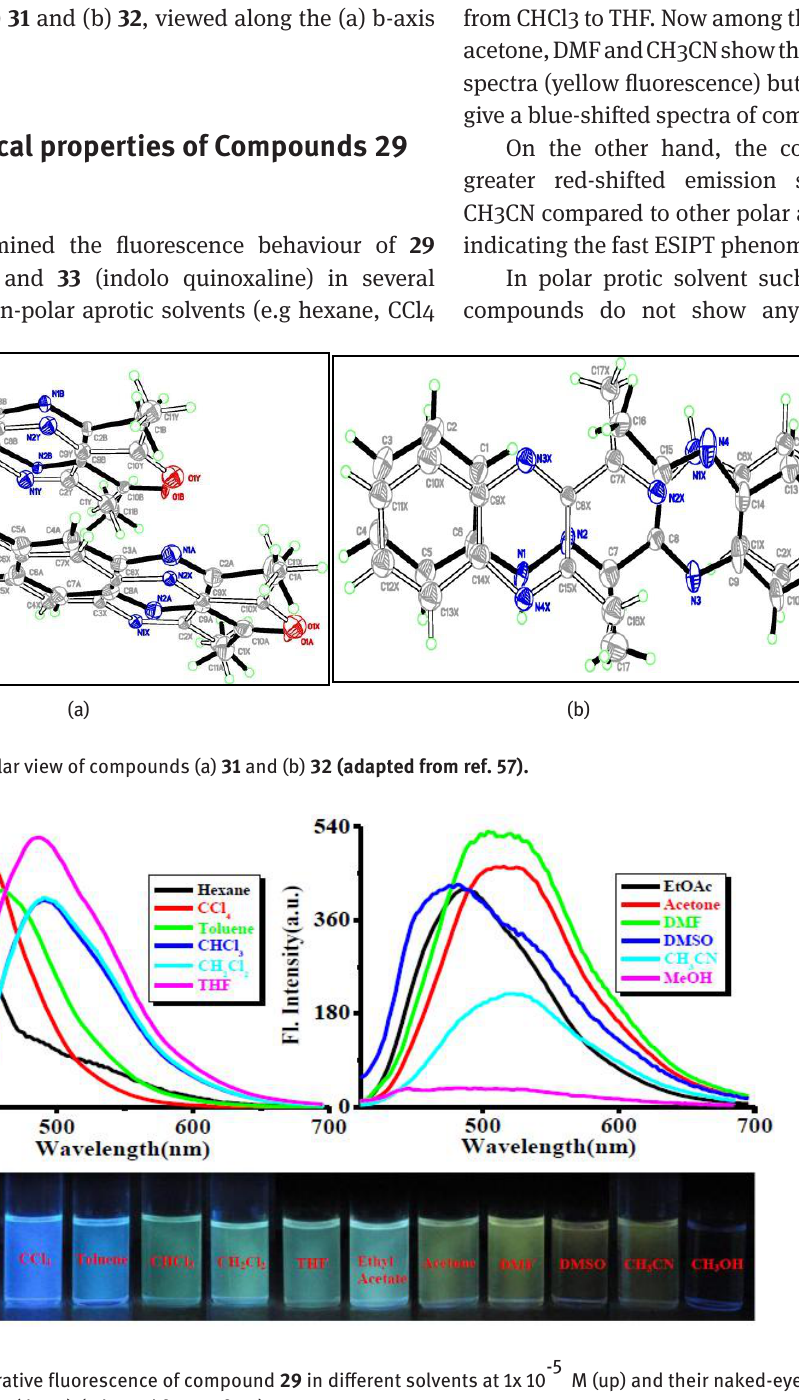
10-5 M (up) and their naked-eye flurescence change under